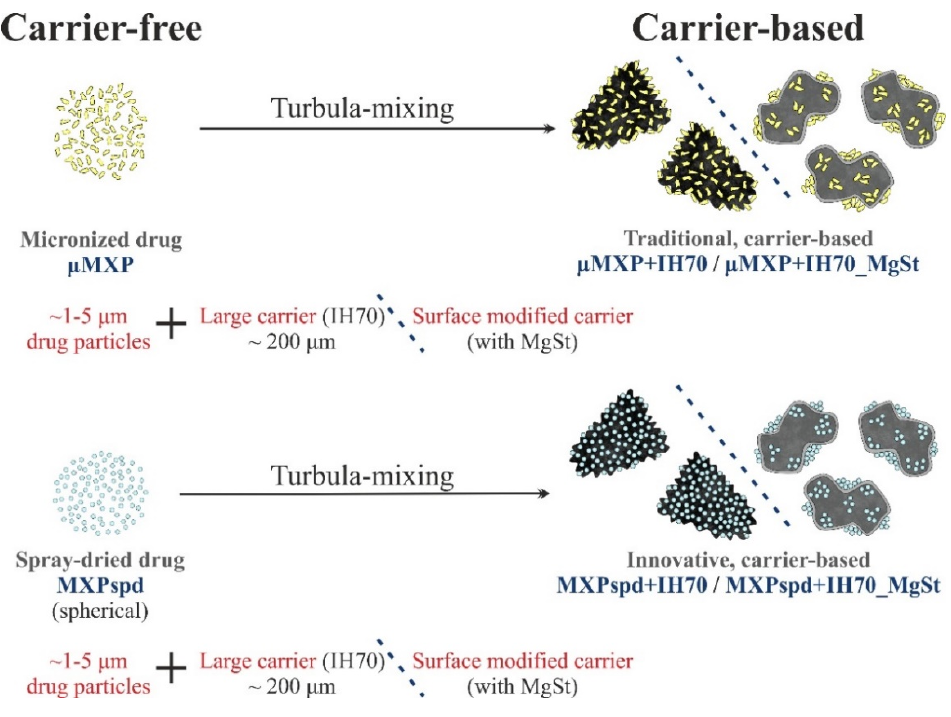
Figure 1. Schematic overview of the preparation. Table 1. The composition of the prepared dry powder inhalation (DPI)